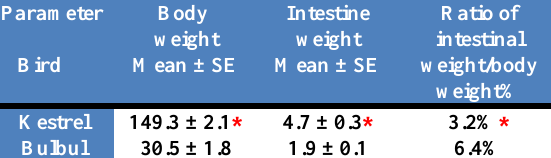
Table, 2: the body weight (gm), small intestine weight (gm) and the ratio of (IW/BW) in kestrel and bulbul.